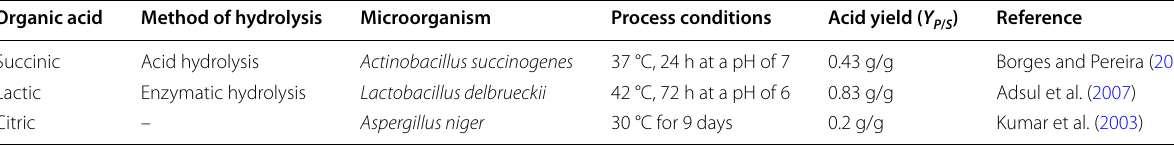
Table 6 Summary of organic acid production from SCB